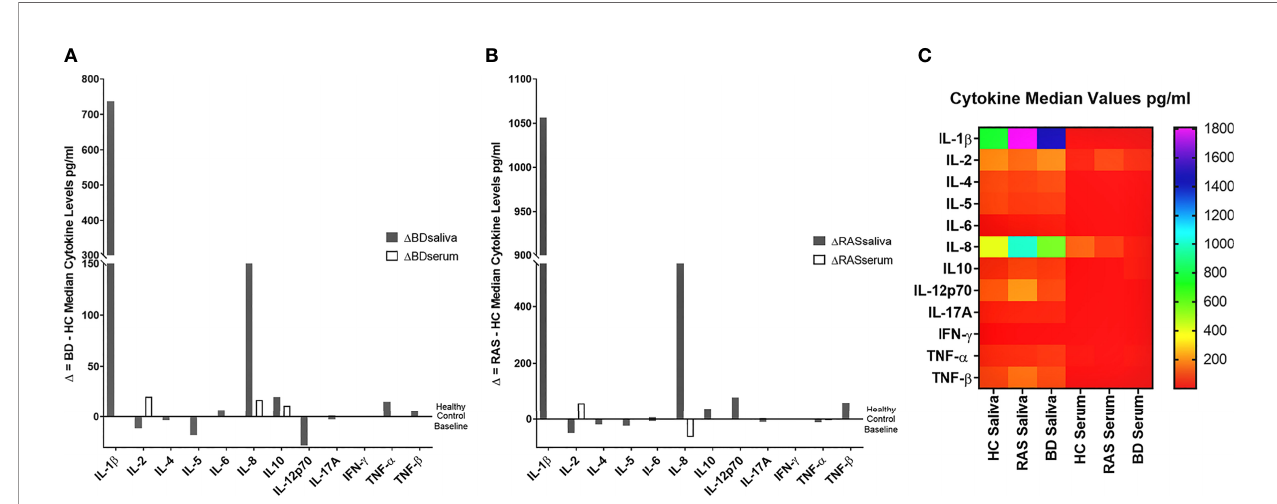
FIGURE 2 | Group median cytokine differences between (A) BD and HC and (B) RAS and HC. For each cytokine, the following was calculated: Group Median BD cytokine concentration (pg/ml) - Group Median HC cytokine concentration (pg/ml) or Group Median RAS cytokine concentration (pg/ml) - Group Median HC cytokine concentration (pg/ml) to reveal the delta ( D ), or difference, of the disease group cytokine levels and the HC. (C) Heat map shows differential expression of 12 cytokines in saliva and